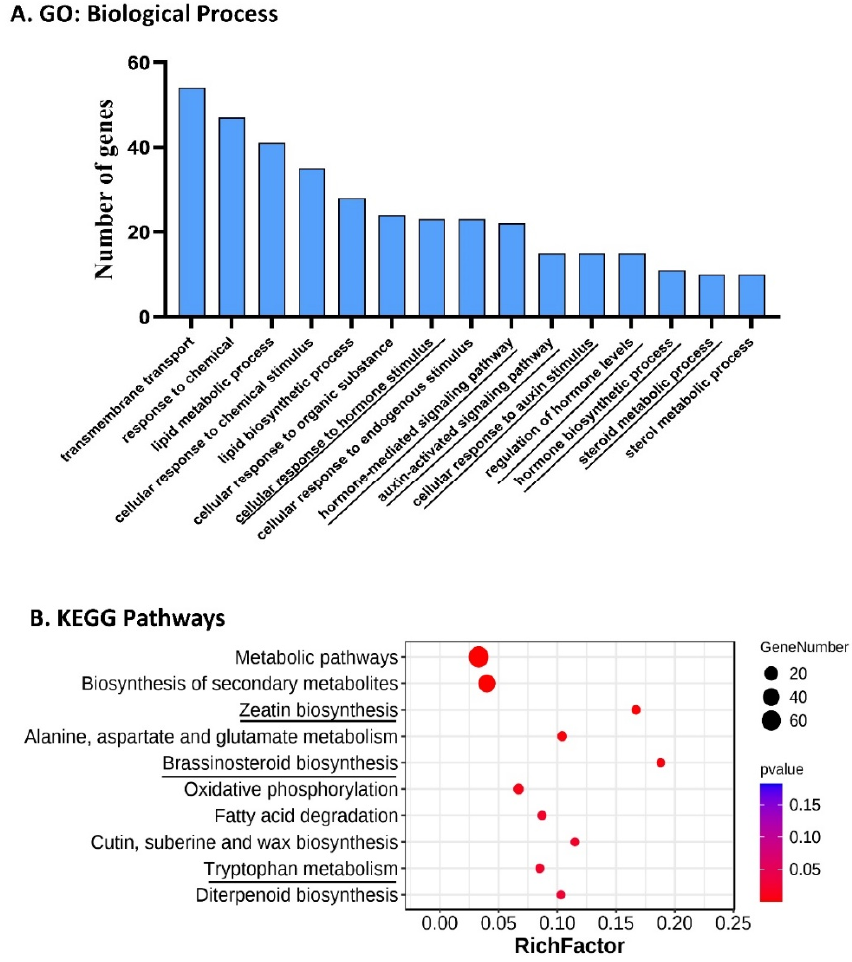
Figure 6. Gene ontology (GO) and KEGG pathway enrichment analyses of transcriptomes of the ovaries at anthesis between WI7237 and fs5.2-WI7237. ( A , B ) are significantly enriched biological process and KEGG pathway terms ( p < 0.05) of the 437 DEGs,